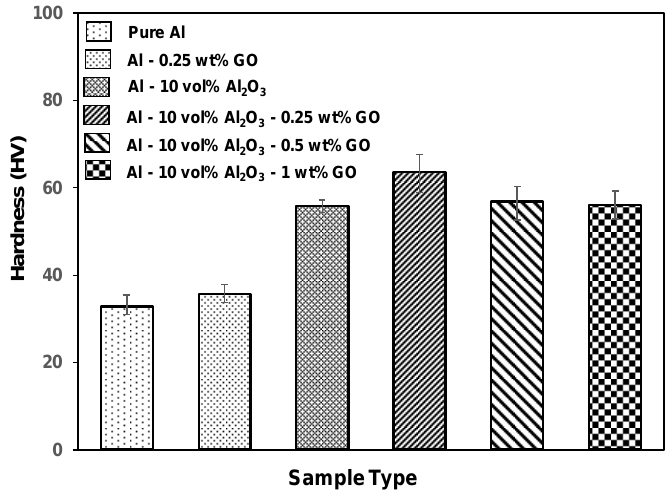
Figure 1. Variation of the hardness of Al nanocomposite and hybrid nanocomposites.